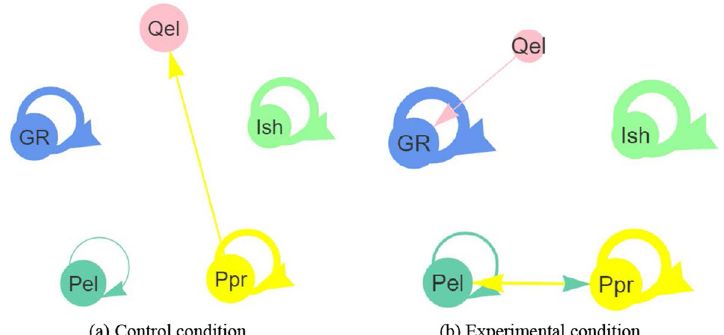
Fig. 5 Transitions between two codes under two conditions